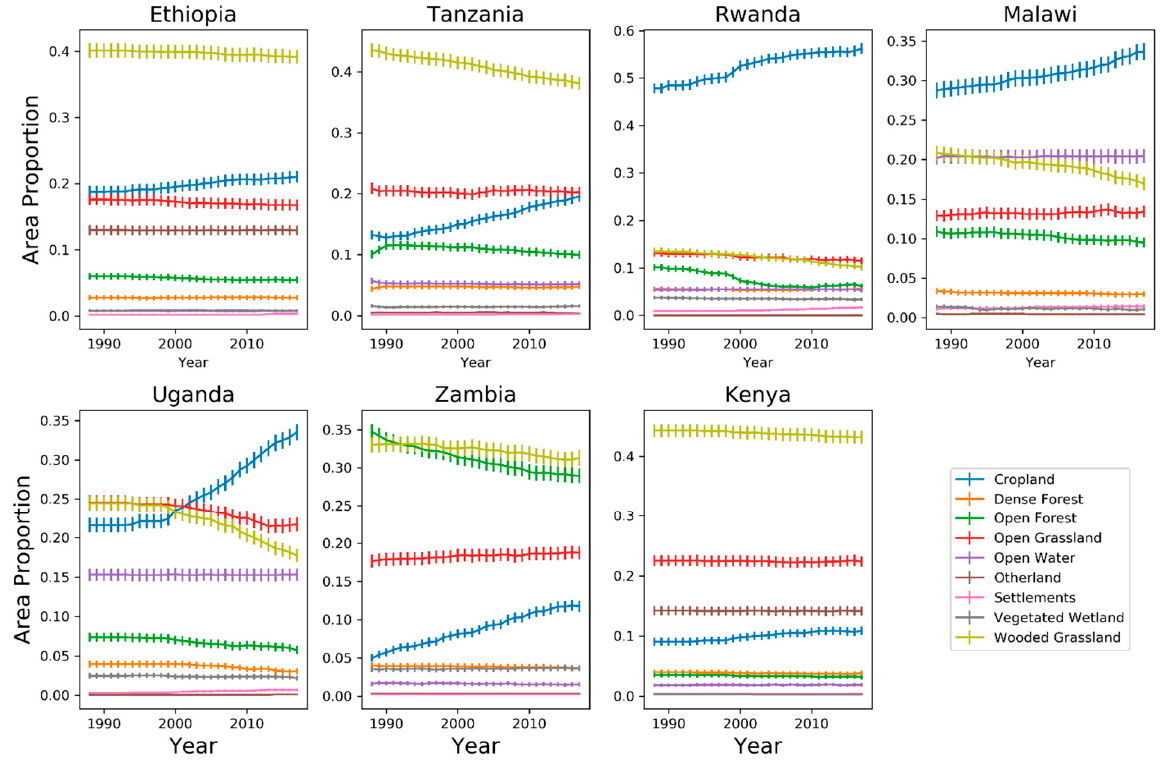
Figure 4. The yearly proportion of land cover classes for each country in the study region. Note that Uganda and Zambia changed in the land cover representing the largest proportion of the country.